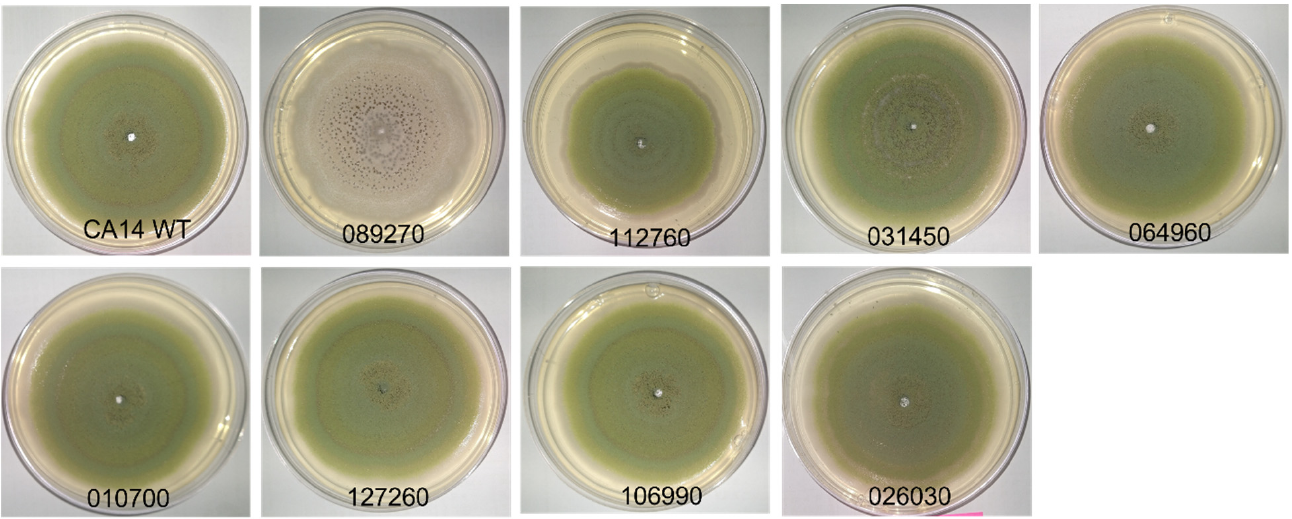
Figure 1. A. flavus knockout strains with the indicated transcription factors deleted were grown on PDA for 7 days at 30° C under 12 hr light/dark cycles. CA14 positive control shows a wild-type phenotype of green pigmentation associated with spore production. AFLA_089270 exhibits a lack of green pigmentation associated with spore production in CA14.